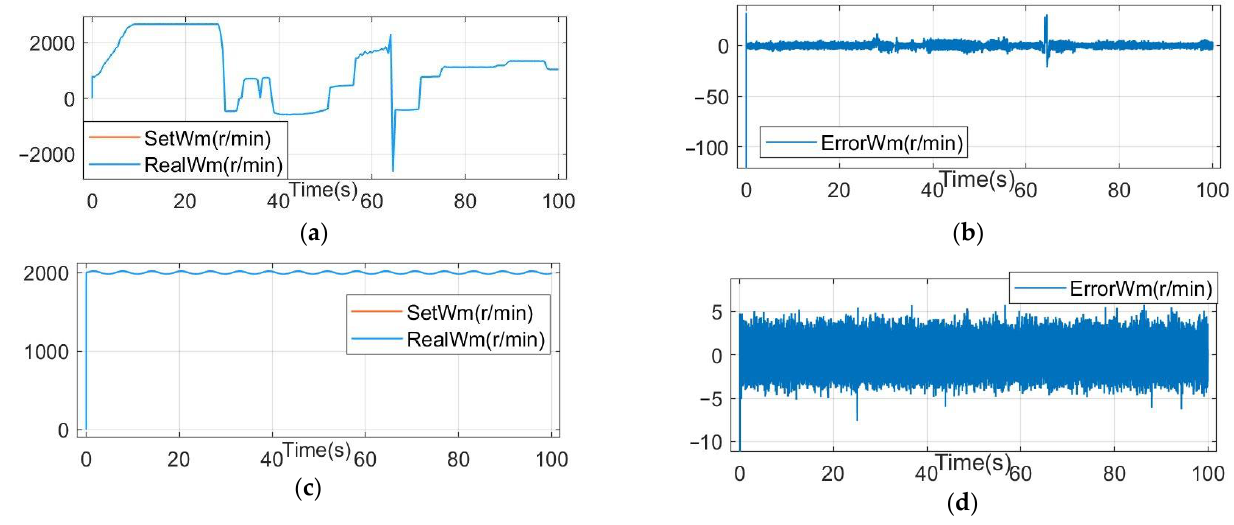
Figure 3. Speed control of the thruster in a normal state: ( a ) thruster speed control, with the reference signal; ( b ) control error of the thruster, using the reference signal; ( c ) thruster speed control, with the sinusoidal signal; ( d ) control error of the thruster, using a sinusoidal signal.